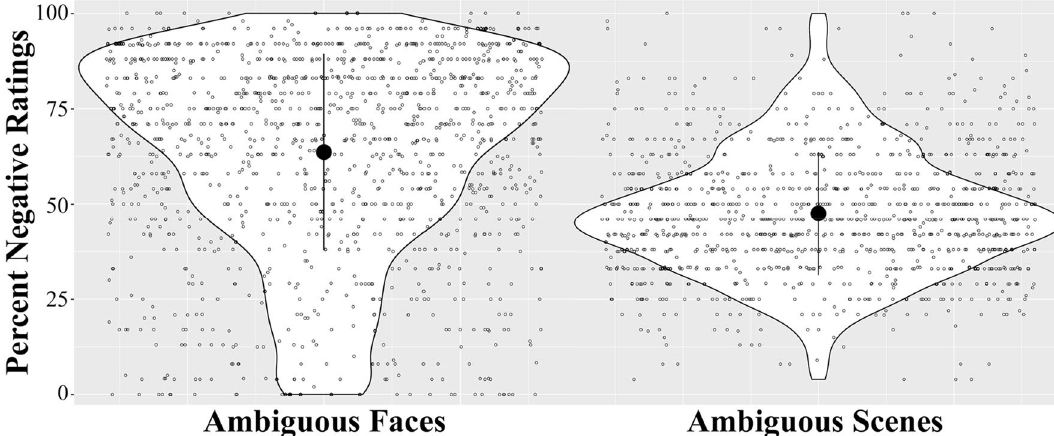
Figure 1. Distribution of valence bias (operationalized as percent negative ratings) in response to ambiguous (surprised) faces and scenes. The central dot represents the mean, and whiskers represent standard deviation; each participant is plotted with an open circle.